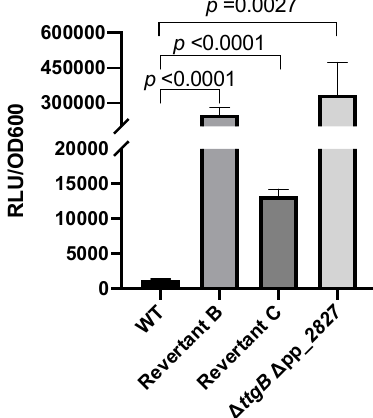
Figure 6. Promoter activity of the mexEF-oprN operon in P. putida KT2440 in presence of Bip. Overnight cultures of the strains containing the transcriptional fusion of the promoter of mexEF-oprN and the luxCDABE operon (in plasmid pBBR1-MCS5- lux ) were grown in KB in presence of 0.5 mM Bip and 30 μg/mL gentamicin. After 8 h, relative light units (RLU) were normalized against the OD 600 . Data are presented as an average of at least three biological replicates.